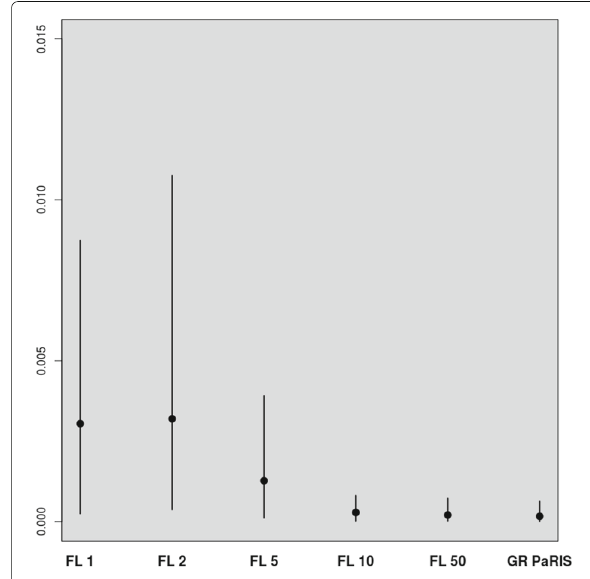
Fig. 9 Log-growth model - bias. Distribution of the empirical absolute relative bias